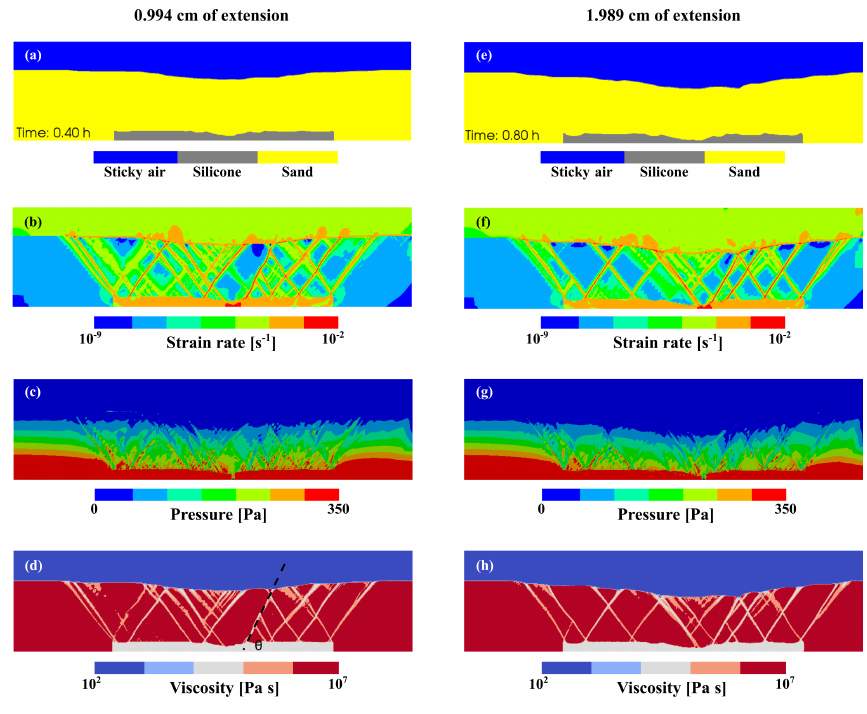
Figure 9. Results after ∼ 1 and ∼ 2cm of extension of the numerical sandbox. (a, e) The three compositional fields. Note the asymmetric depression of the sand surface. (b, f) Frobenius norm of the strain rate